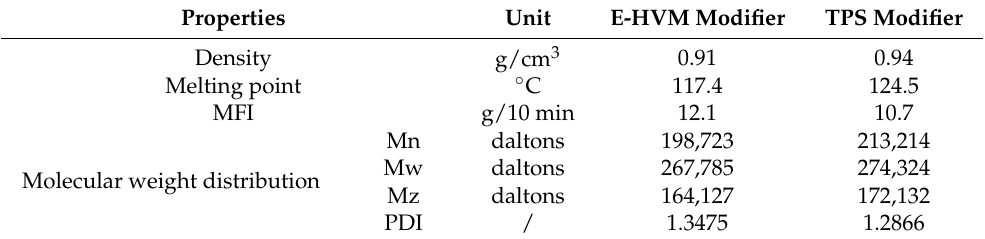
Table 4. The physical characteristics of two